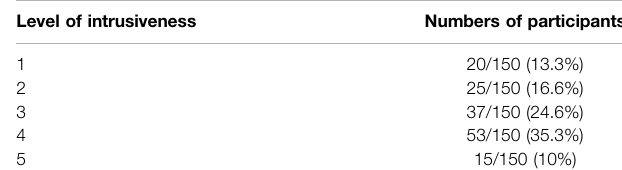
TABLE 9 | Perceived level of intrusiveness on a scale from 1 to 5 (5 is very